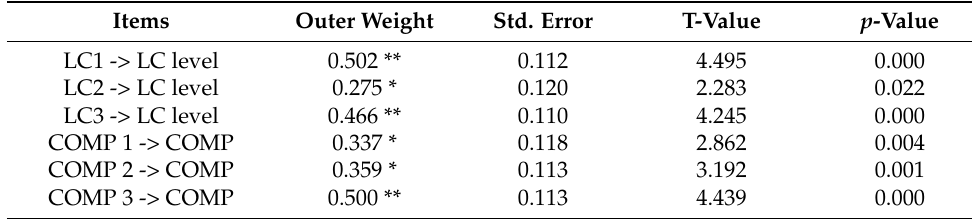
Table 12. Assessment of formative model.